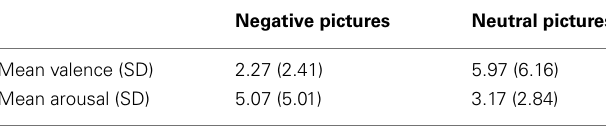
Table 1 | Overview of the selected